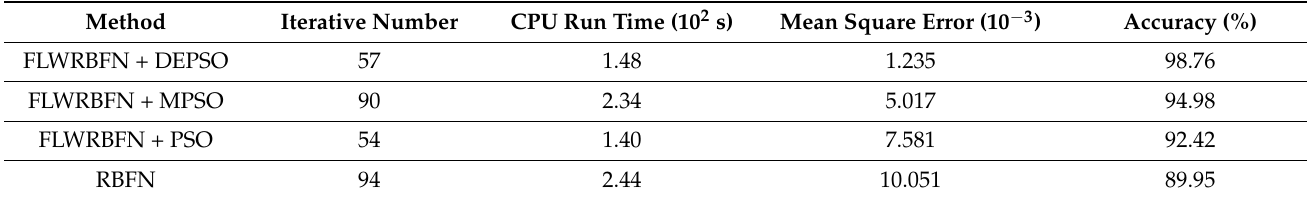
Table 1. Quantitative comparison for several methods with load